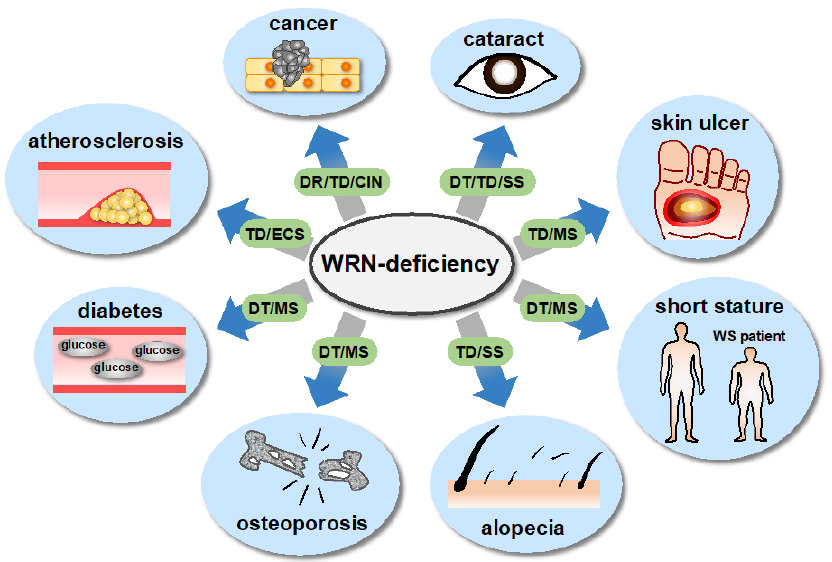
Figure 2. The link between molecular processes associated with WRN helicase and pathologi- cal/clinical features. WS patients present with a variety of symptoms associated with aging. Recent studies suggest which of the patient’s symptoms are related to specific molecular-level abnormalities caused by a deficiency of WRN helicase, and the cell types affected as a result. The patient’s symptoms are shown in bold letters in the outermost circle, and the suggested molecular abnormalities and the resulting affected cell types are shown as abbreviations in the middle circle. Note: CIN = chromoso- mal instability; DR = dysfunction in repair; DT = dysfunction in transcription; ECS = endothelial cell senescence; MS = mesenchymal cell senescence; SS = stem cell senescence; TD = telomere dysfunction.